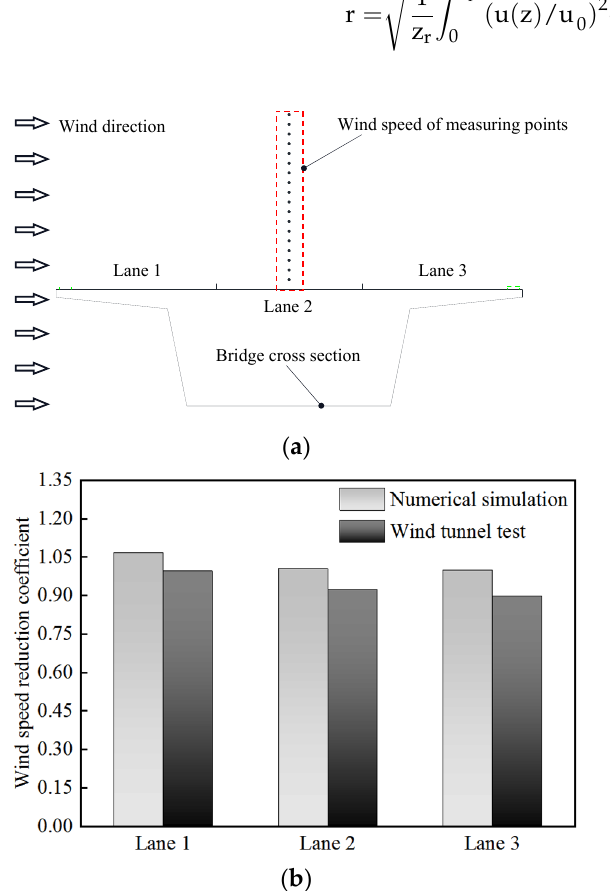
Figure 5. Wind speed reduction coefficient (r) comparison for the bare bridge condition (( a ) Measuring points and lane layout; ( b ) wind speed reduction coefficient of the bare bridge for different